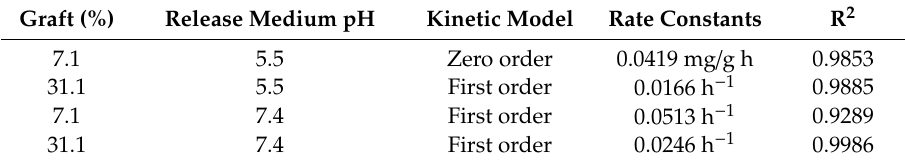
Table 1. Release kinetics